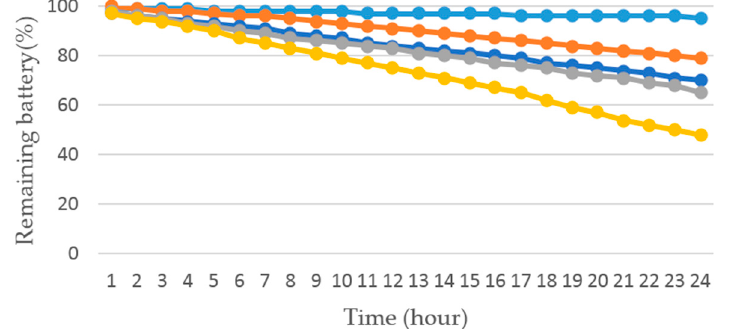
Figure 14. Remaining battery at different sampling rates and in idle state.